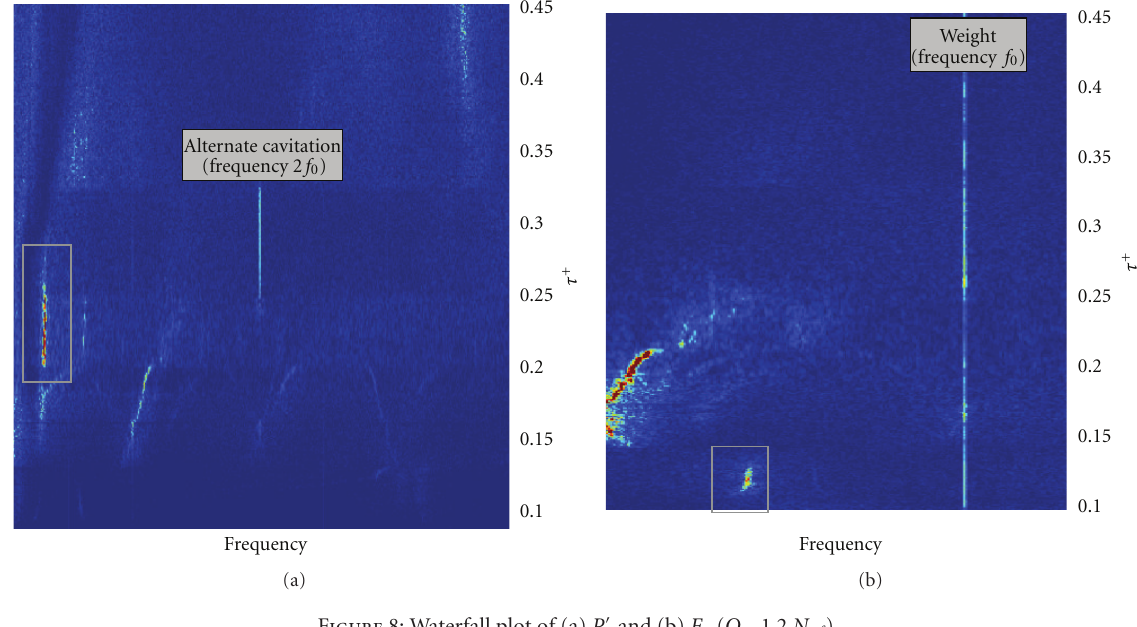
Figure 8: Waterfall plot of (a) P (cid:3) 2 and (b) F y ( Q n , 1.2 N ref ).